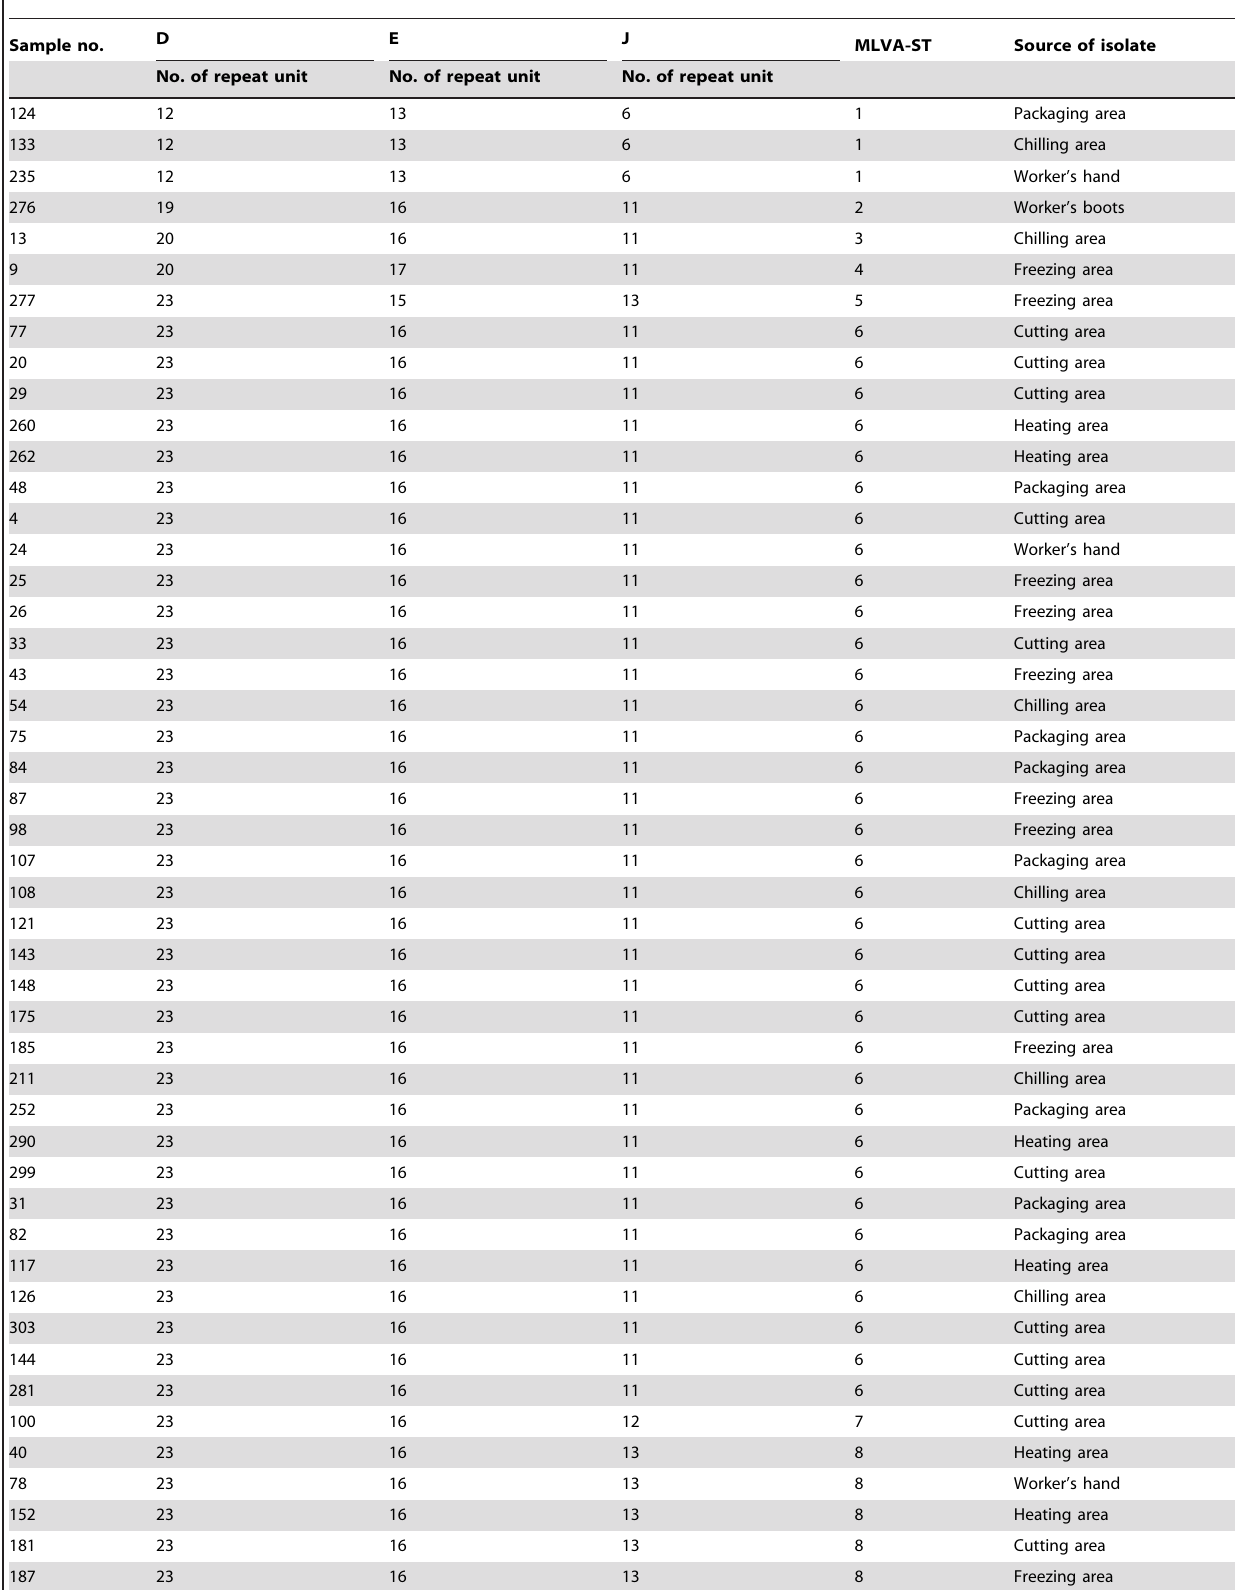
Table 5. The result of MLVA analysis for 60 L. innocua isolated from food processing plant.